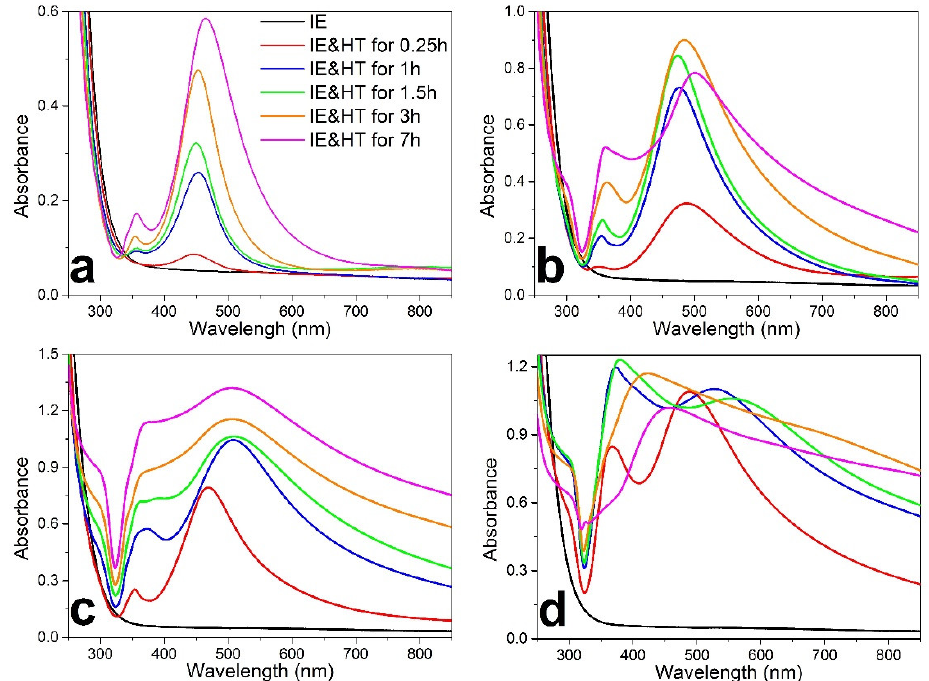
Figure 3. Absorbance spectra of PTR-M glass sample after the Na + –Ag + IE and with SNIF obtained at 350 °C ( a ), 400 °C ( b ), 450 °C ( c ), and 500 °C ( d ) for different durations, indicated by